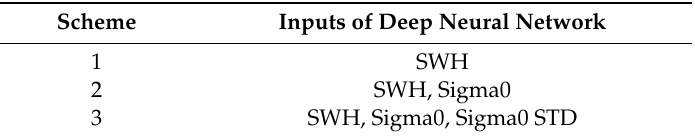
Figure 5. The structure of deep neural network for SWH calibration scheme 3. Table 1. Input schemes of deep neural network (DNN) for SWH